Question: In one sentence, what is this figure communicating?
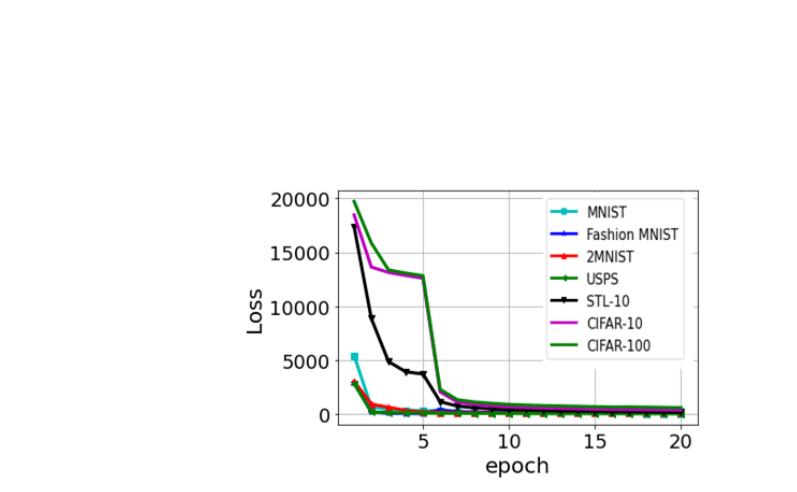
Answer: The second phase’s loss function of DCSS for different benchmark datasets.